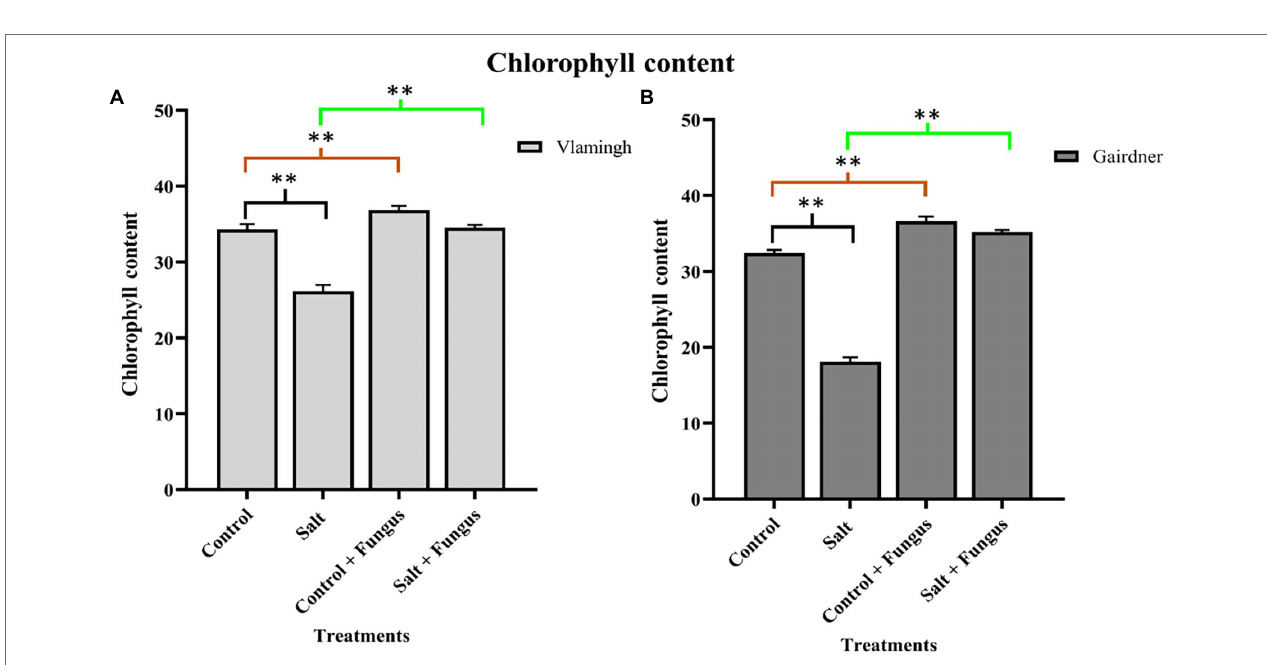
FIGURE 3 | Leaf chlorophyll content of two barley genotypes cv. Vlamingh (A) and cv. Gairdner (B) measured using SPAD metre. The four treatments are represented on the X axis, and the chlorophyll index is represented on the Y axis. Different comparisons are represented by three colour bars above the graphs: black represents comparisons between salt and control, light brown represents comparisons between control + fungus and control, and cyan green represents comparisons between salt + fungus and salt. As determined by Student’s t-test, asterisks imply significance for p < 0.01 (two